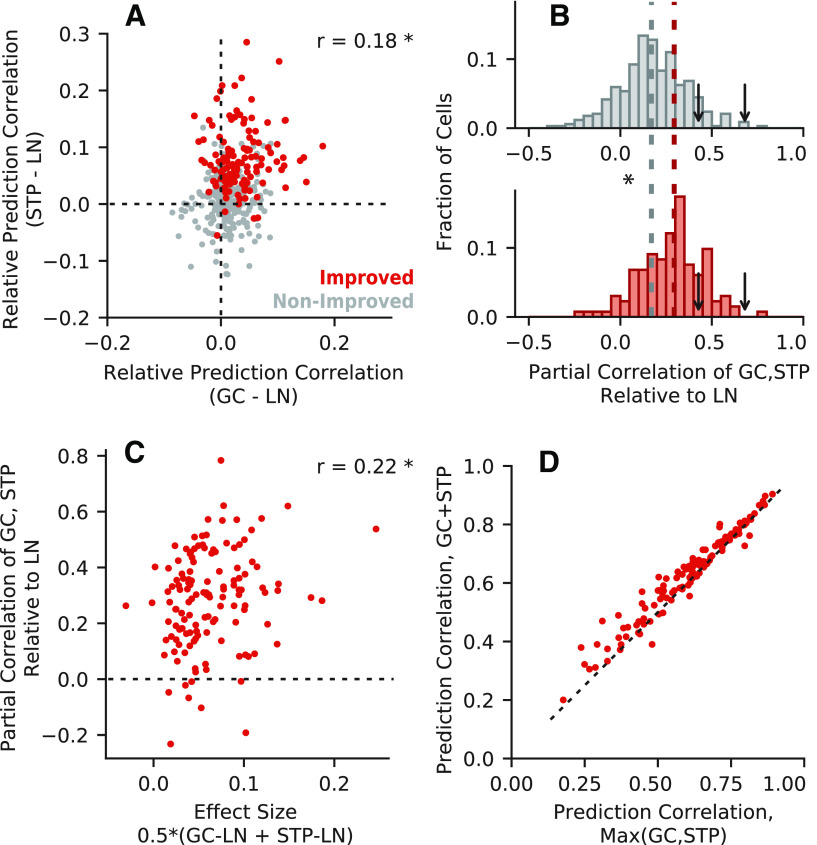
Equivalence of model predictions. A, Difference in prediction correlation between the GC (horizontal axis) or STP (vertical axis) model and the LN model for each neuron (r = 0.18, *p = 6.42 × 10−5). Red points indicate neurons with a significant improvement for the GC+STP model over the LN model (p < 0.05, permutation test); gray points indicate neurons that were not improved. B, Histogram of model equivalence for each unit, measured as the partial correlation between time-varying response predicted by the STP and GC models relative to the LN model prediction. Median equivalence for improved cells (0.29, bottom, red) was significantly greater than for non-improved cells (0.17, top, gray; Mann–Whitney U test, *p = 1.72 × 10−8). Arrows indicate median partial correlation for the GC model (0.43, left) and the STP model (0.68, right) when compared within-model, adjusted for differences in estimation data. C, Scatter plot compares equivalence (vertical axis) versus effect size (horizontal axis), i.e., the average change in prediction correlation for the STP and GC models relative to the LN model, for improved cells. Only a weak relationship between equivalence and effect size was observed (r = 0.22, *p = 0.0103). D, Prediction correlations for the combined GC+STP model (vertical axis) and the maximum of the GC and STP models (horizontal axis) for improved cells. Median prediction correlation was significantly higher for the combined model (0.6568) than for the greater of the individual models (0.6319; Wilcoxon signed-rank test, p = 1.41 × 10−14).